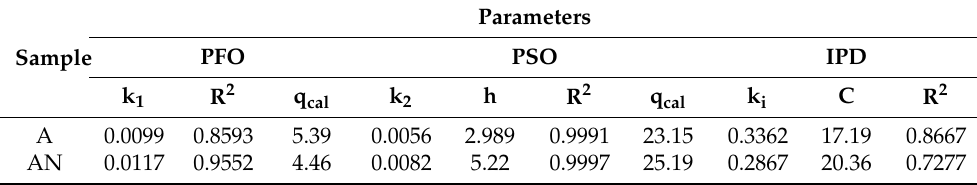
Table 2. Kinetic parameters for Cu 2+ adsorption on the activated carbons C init = 10 mg/L.